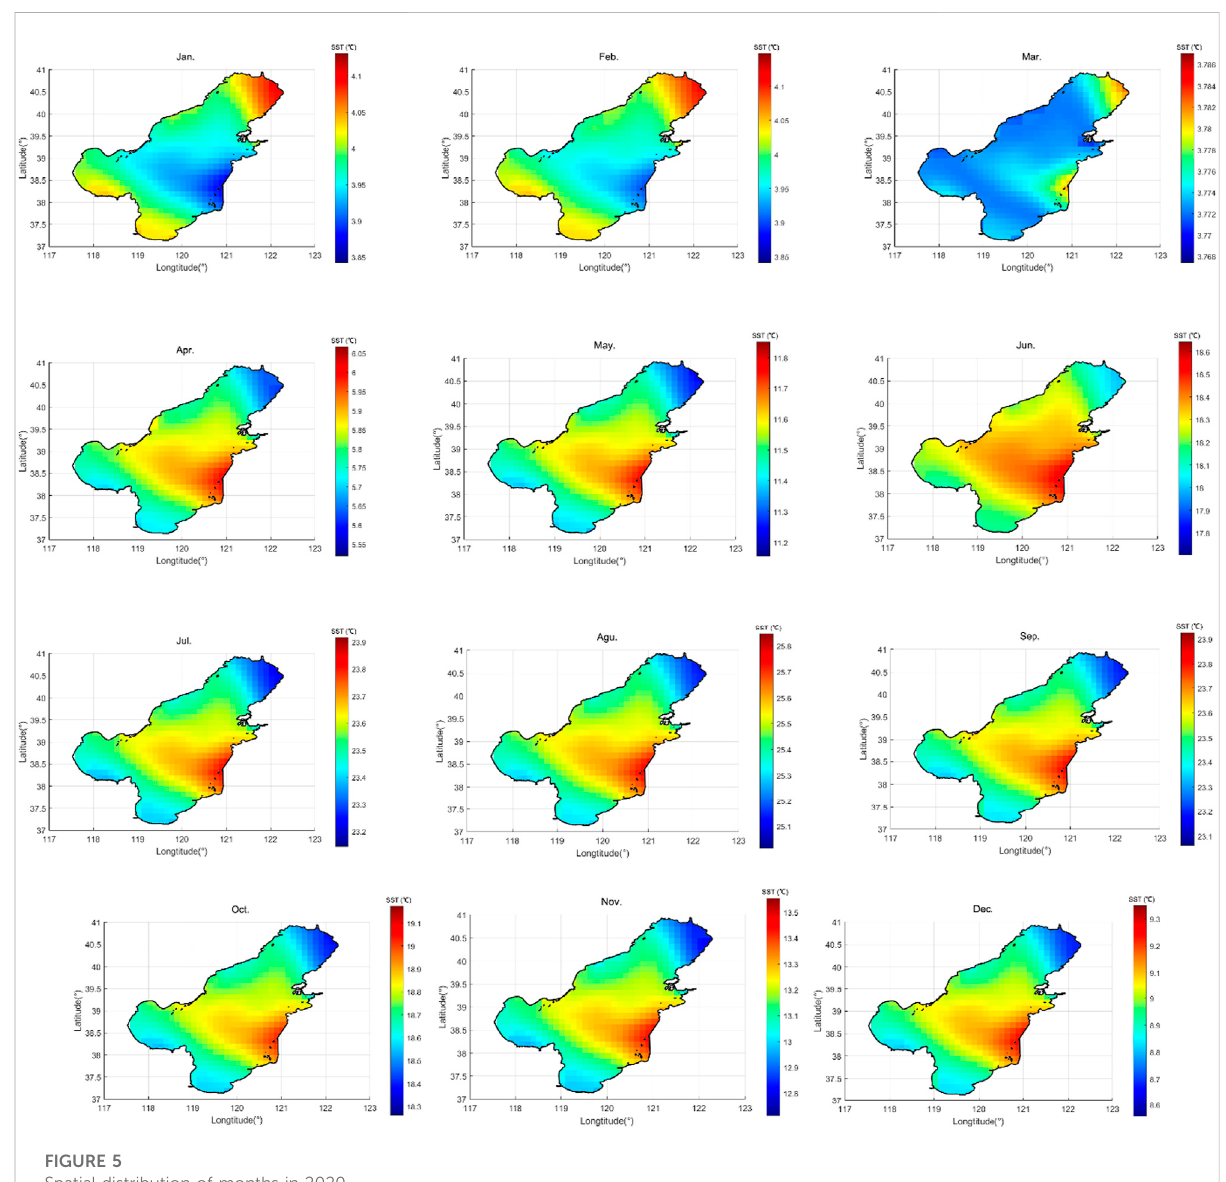
FIGURE 5 Spatial distribution of months in